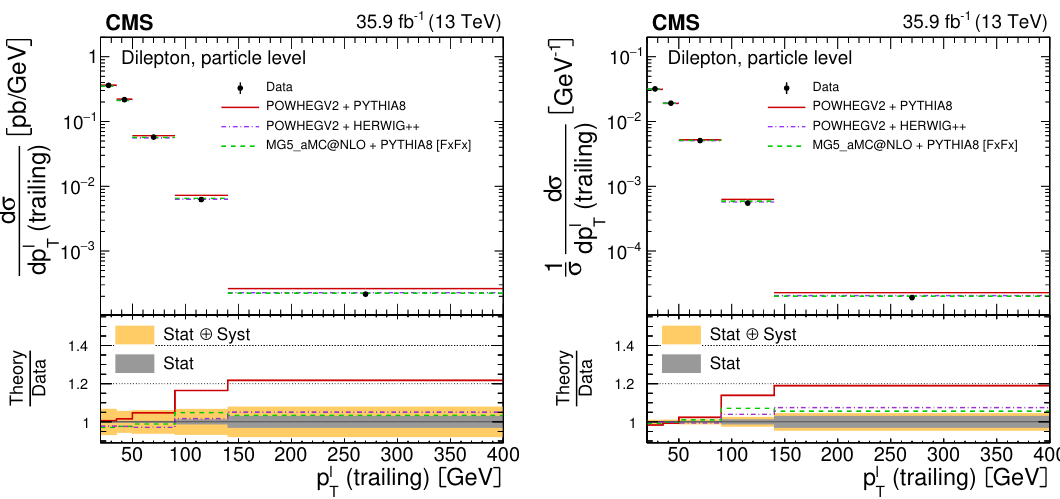
Figure 36 . The di(cid:11)erential tt production cross sections as a function of p ‘ phase space at the particle level are shown for the data (points) and the MC predictions (lines). The vertical lines on the points indicate the total uncertainty in the data. The left and right plots correspond to absolute and normalised measurements, respectively. The lower panel in each plot shows the ratios of the theoretical predictions to the data. The dark and light bands show the relative statistical and total uncertainties in the data, respectively.